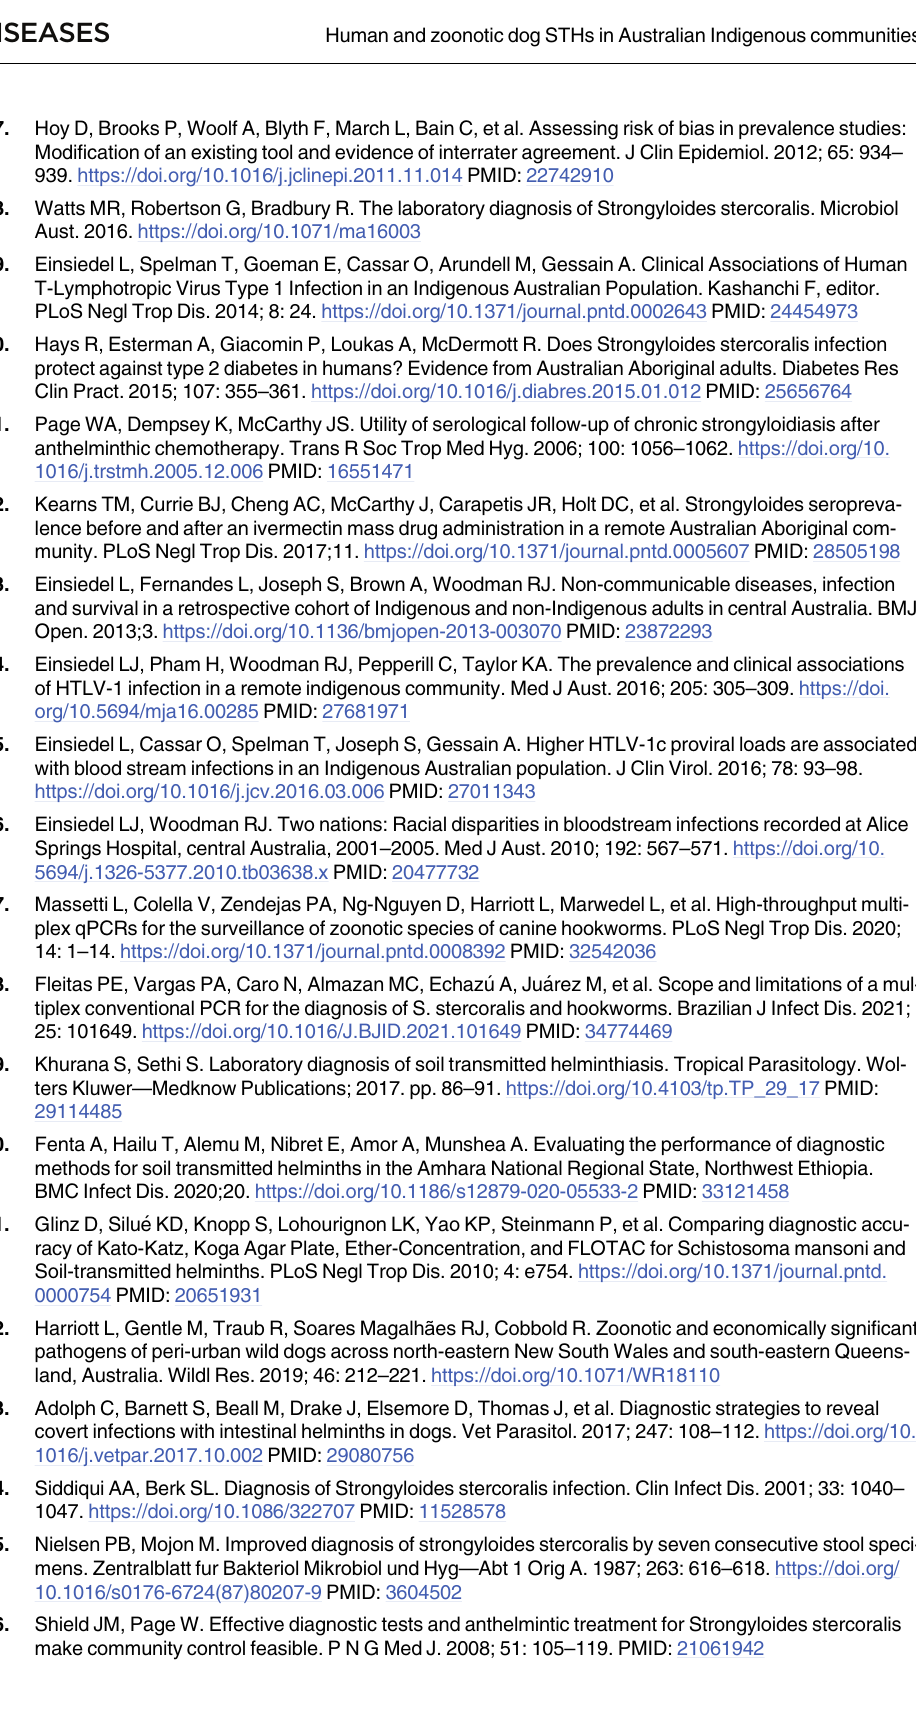
66. ShieldJM, Page W. Effective diagnostic tests and anthelmintic treatment for Strongyloides stercoralis make community control feasible.P N G Med J. 2008; 51: 105–119.PMID: